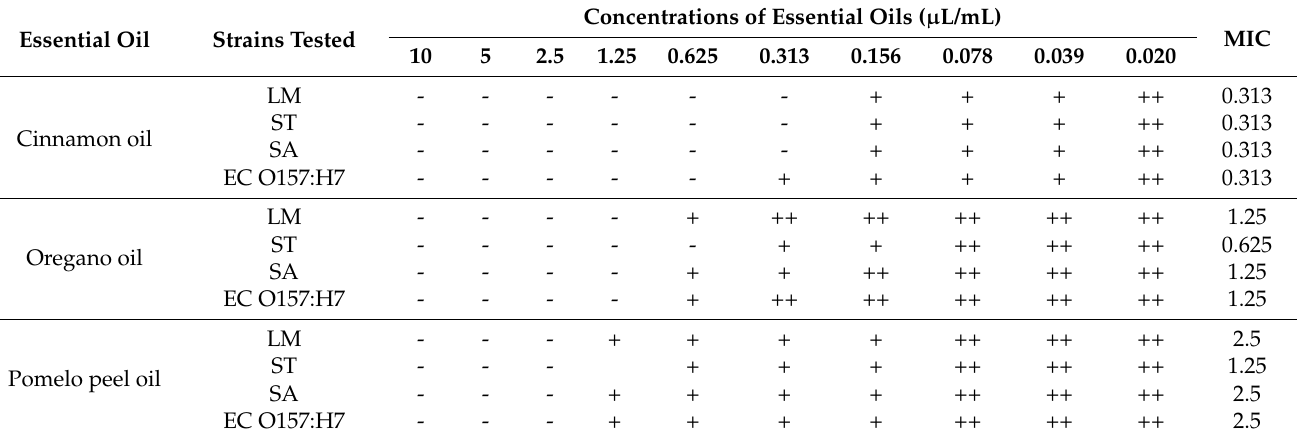
Table 2. Minimal inhibitory concentrations (MIC) of cinnamon, oregano, and pomelo peel